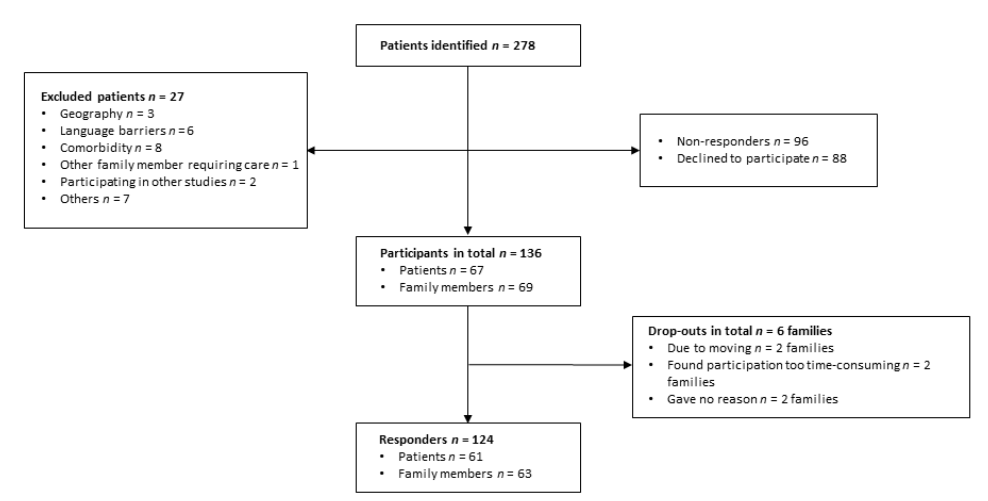
Figure 1. Flow Figure 1. Flow chart.